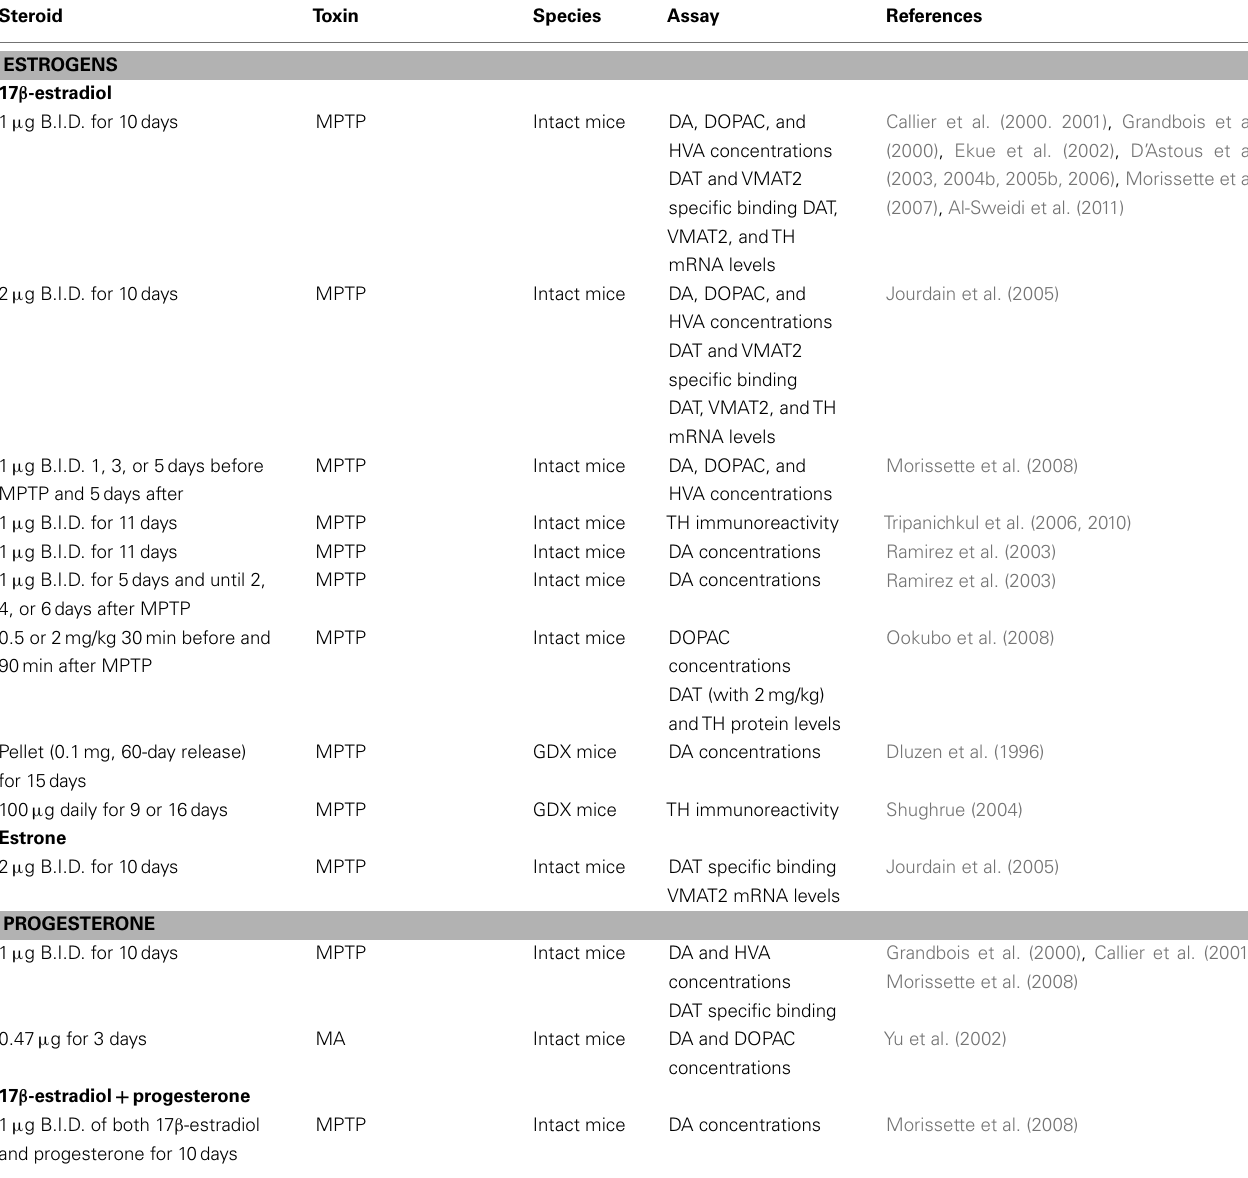
Table 3 | In vivo studies and neuroprotection in male rodents: studies showing protection of DA markers.